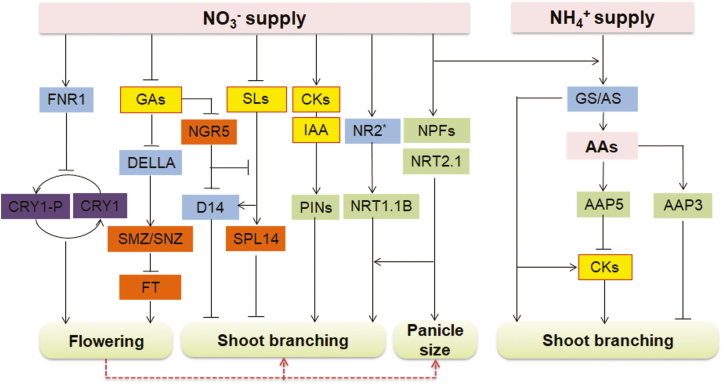
Outline of nitrogen (N) regulatory pathways altering plant architecture under conditions of nitrate (NO3–) and ammonium (NH4+) supply. NO3– influences shoot branching, flowering time, and panicle size. NO3– suppresses the expression of ferredoxin–NADP oxidoreductase 1 (FNR1), which modulates cryptochrome 1 (CRY1) phosphorylation and delays flowering (Yuan et al., 2016). The transcription factors SCHLAFMUTZE (SMZ) and SCHNARCHZAPFEN (SNZ) can be activated by NO3– via the gibberellic acid (GA) pathway to suppress flowering (Gras et al., 2018). The flowering time can directly or indirectly alter branching and panicle structure. In addition, N supply rapidly stimulates cytokine (CK) biosynthesis and acropetal transportation (Liu et al., 2011; Ohashi et al., 2017). Branching is regulated by the varied distribution of auxin, which is regulated by the expression of members of the PIN-FORMED family of auxin efflux transporters (PINs) via CKs and NO3– (Sun et al., 2014). The biosynthesis of strigolactones (SLs) is suppressed by a sufficient N supply, resulting in the outgrowth of branching (Yoneyama et al., 2007, 2012; Xie et al., 2010). Moreover, the expression of indica-type nitrate reductase 2 (NR2; indicated with an asterisk) and the nitrate transporter 1.1B (NRT1.1B) can be induced by NO3– and enhances the absorption of NO3– and the regulation of branching (Hu et al., 2015; Gao et al., 2019). Expression of the nitrate transporter 2.1 (NRT2.1) gene and putative nitrate–peptide transporter family genes (NPFs) can enhance panicle size and branching (Chen et al., 2016; Huang et al., 2018, 2019b). Amino acids (AAs) influence shoot branching. The putative amino acid permease AAP3 can suppress branching, while AAP5 can alter branching by regulating the CK level (Lu et al., 2018; Wang et al., 2019b). Glutamine synthetase (GS), such as OsGS1.2, and asparagine synthetase (AS) can mediate the synthesis of CKs for the regulation of branching (Funayama et al., 2013; Ohashi et al., 2015, 2017; Luo et al., 2019). CRY1-P, phosphorylated CRY1; D14, Dwarf14 (an SL receptor); FT, flowering locus T; NGR5, nitrogen-mediated tiller growth response 5; SPL14, squamosa promoter binding protein-like 14. Arrows represent enhancement of downstream target activity. Lines with a horizontal bar at the end represent suppression of downstream target activity. Dashed lines indicate that the evidence for the regulation is not strong. Phytohormones are highlighted in yellow, transporters in green, enzymes in blue, and transcription factors in orange.